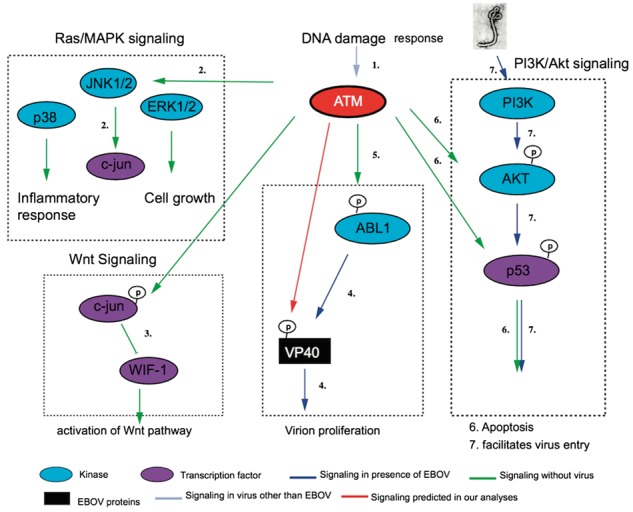
The role of ATM kinase in EVD related signaling pathways. Red arrows indicate novel interactions predicted in our analyses. Other arrows are derived from literature 1. (Xiaofei and Kowalik, 2014) 2. (Munshi and Ramesh, 2013) 3. (Svegliati et al., 2014) 4. (Garcia et al., 2012) 5. (Shafman et al., 1997) 6. (Shiloh and Ziv, 2013) 7. (Saeed et al., 2008)